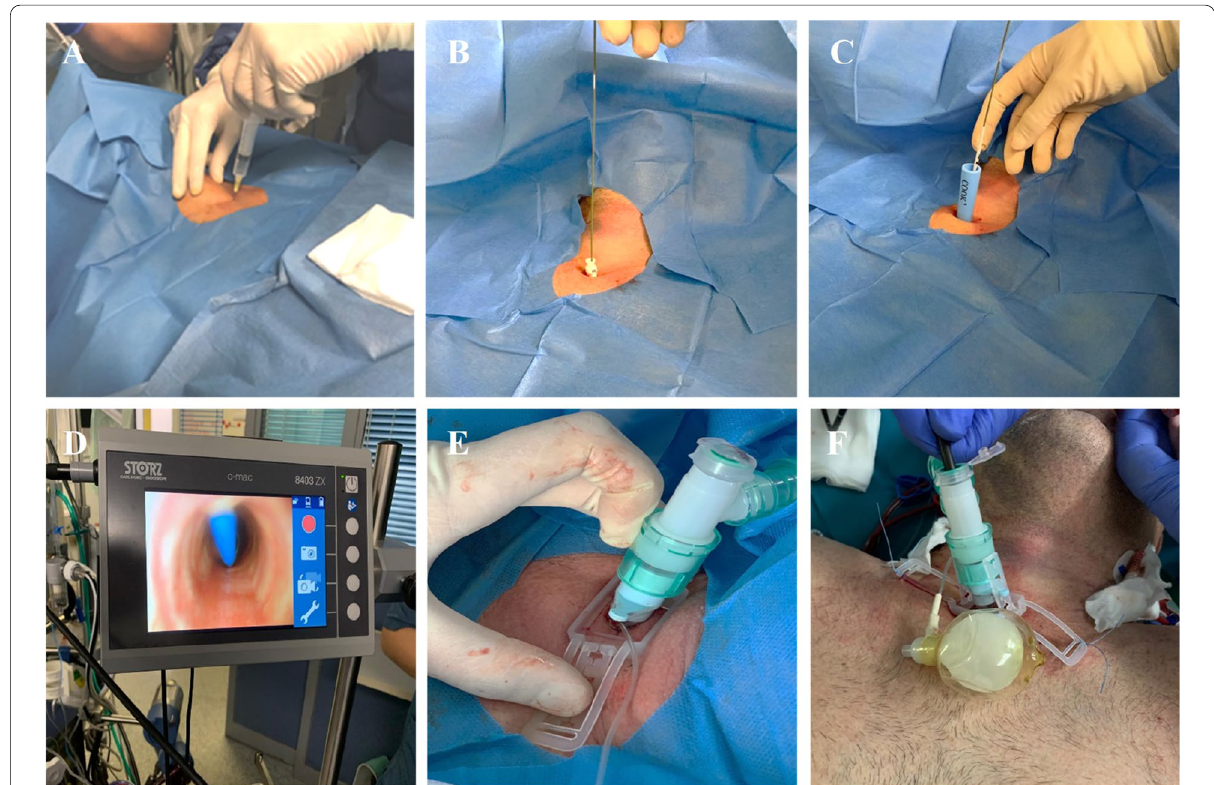
Fig. 2 Percutaneous dilatational tracheotomy according to Ciaglia’s technique. Percutaneous dilatational tracheotomy according to Ciaglia’s technique with accompanying bronchoscopy: first, a colour Doppler ultrasound examination may be performed to ensure that no blood vessels run below the intended puncture site. After administration of local anaesthesia ( A ), median puncture of the trachea below the second or third tracheal clasp under bronchoscopic visualization and insertion of a Seldinger wire ( B ) is performed. The Seldinger guidewire is used for bougienage with different dilators (Ciaglia Blue Rhino ® Set, Cook Medical) ( C ) under bronchoscopic visualization ( D ). Subsequently, the tracheal cannula is inserted along an introducer and—after bronchoscopy-guided confirmation of correct localization of the cannula within the trachea and subsequent cuff inflation—connected to the respiratory system ( E ). Final bronchoscopic position control of the tracheal cannula ( F